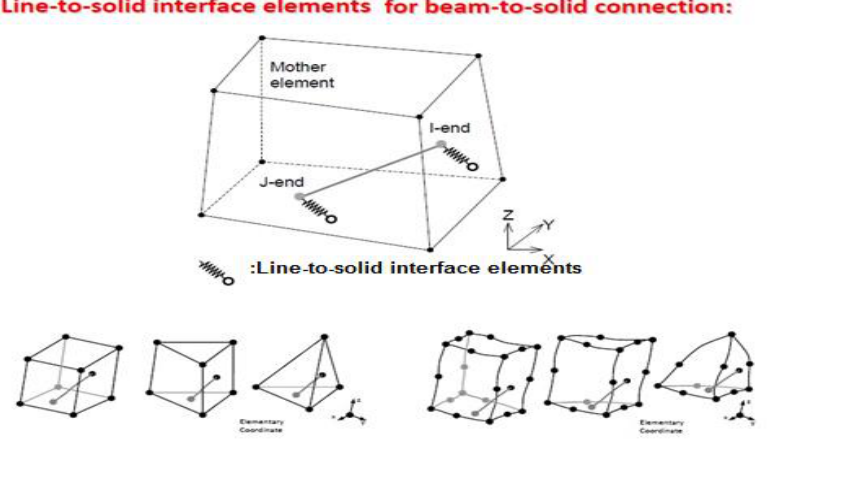
Fig. 8. Line interface elements for lateral friction